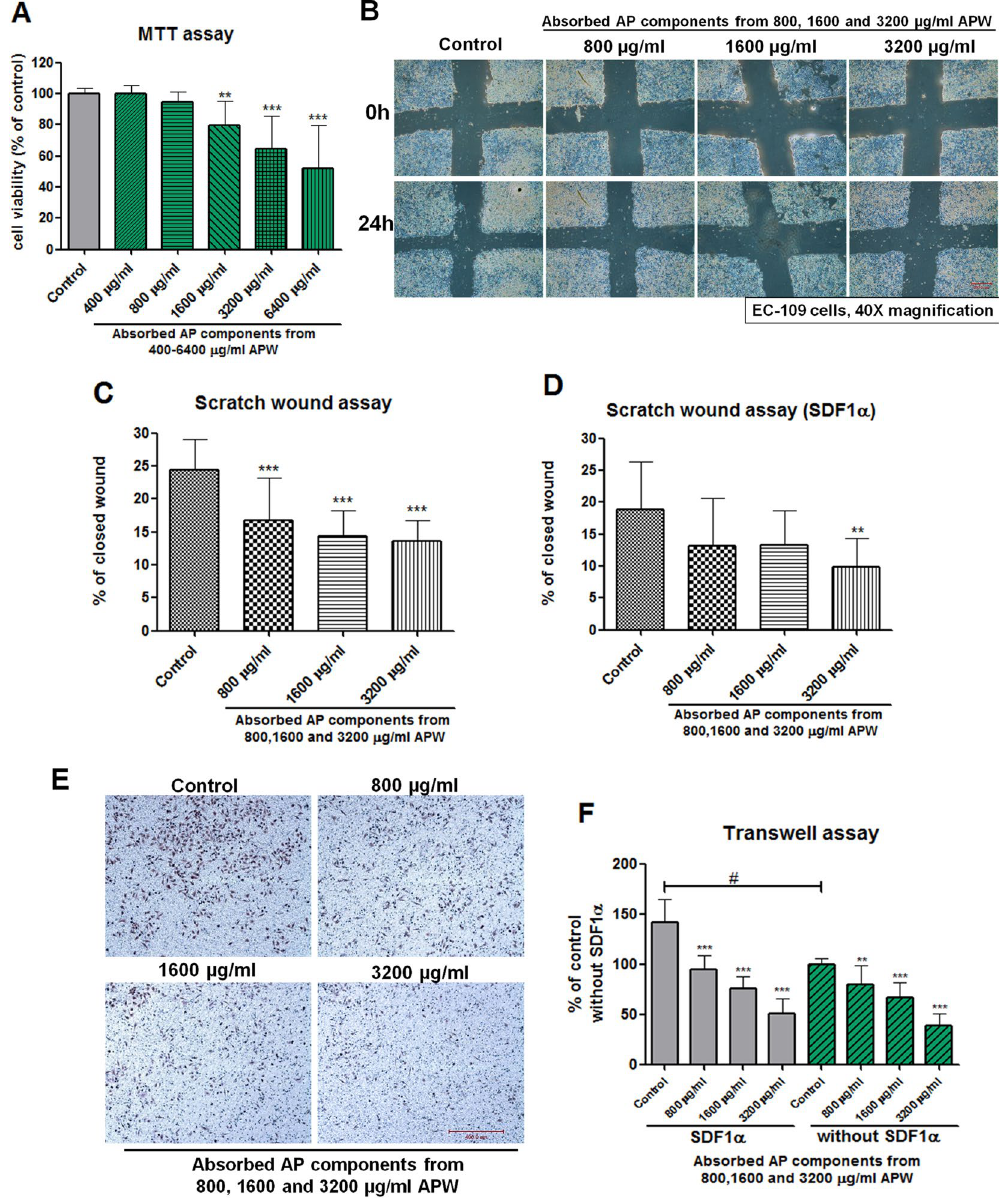
Figure 2. The cytotoxicity and anti-migratory effect of absorbed AP components in EC-109 cells. ( A ) Results showed that when 1600–6400 μ g/mL of APW were added on the apical side of Caco-2 cell monolayer, the absorbed AP components collected on the basolateral side of the monolayer could significantly inhibit the growth of EC-109 cells after 48 h incubation (n = 3–4, mean + SD). ( B – D ) The anti-migration effect of absorbed AP components (AAPC) by scratch wound assay. ( B ) The representative photomicrographs showing human esophageal squamous carcinoma cells EC-109 migrated across the scratch wound in the presence or absence of AAPC for 24 h treatment. ( C and D ) The results are expressed as the percentage of closed wound area (mean + SD of three independent experiments with two wells each). ( E and F ) Effects of absorbed AP components (AAPC) on migration of EC-109 in Boyden chambers. ( E ) Representative photomicrographs showing the stained cells on the lower side of the membrane. The cells in the upper chambers were treated with different doses of AAPC. After 24 h incubation, those cells migrated to the lower chambers were stained and the numbers were counted. ( F ) Quantification of migration of EC-109 cells. Results are expressed as the mean percentage of control (mean + S.D. of three independent experiments with two wells each). Differences between AAPC treated groups and vehicle control group were determined by one-way ANOVA followed by post-hoc Dunnett’s test. ** p < 0.01, *** p < 0.001 comparing AAPC treated groups with vehicle control. Difference between vehicle control groups with and without SDF1 α was determined by Student’s t-test, # p <